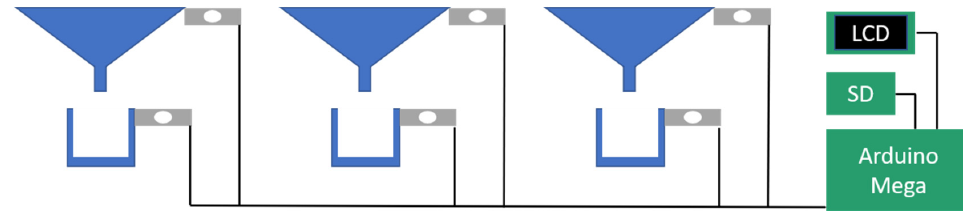
Figure 6. Scheme of the apparatus used for the test.